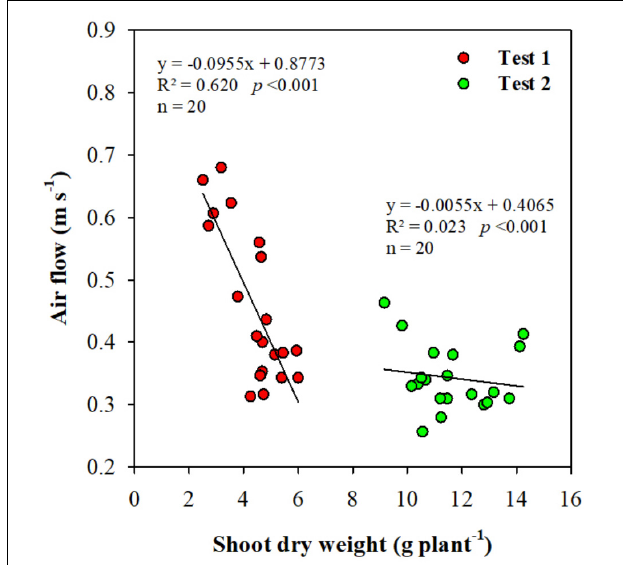
FIGURE 6 | Regression between the air flow velocity at the different trays position ( n = 20) of the Higher Plant Chamber (HPC) and the respective shoot dry weight ( n = 20) in Test 1 and Test 2.